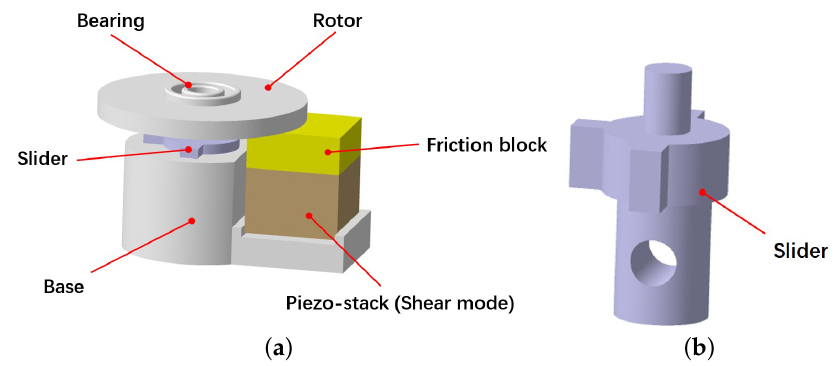
Figure 1. Structural diagram of the piezoelectric actuator: ( a ) overall structure; and ( b ) slider.